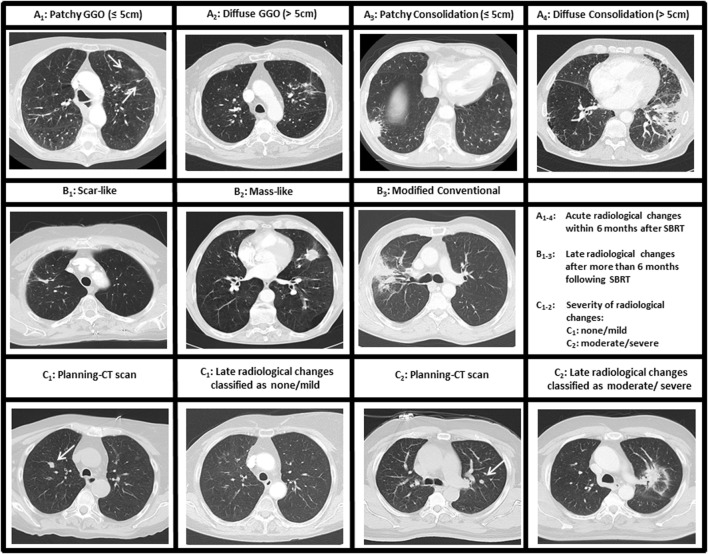
Classification of radiologic changes following stereotactic body radiotherapy (SBRT). (A1–4) Acute parenchymal changes within the first 6 months after SBRT. One category [no parenchymal abnormalities (NPA)] is not shown. (B1–3) Late parenchymal changes after 6 months following SBRT. One category (NPA) is not shown. (C1–2) Severity score for radiologic changes with (C1) classified as no/mild changes and (C2) classified as moderate/severe changes. GGO, ground-glass opacity.